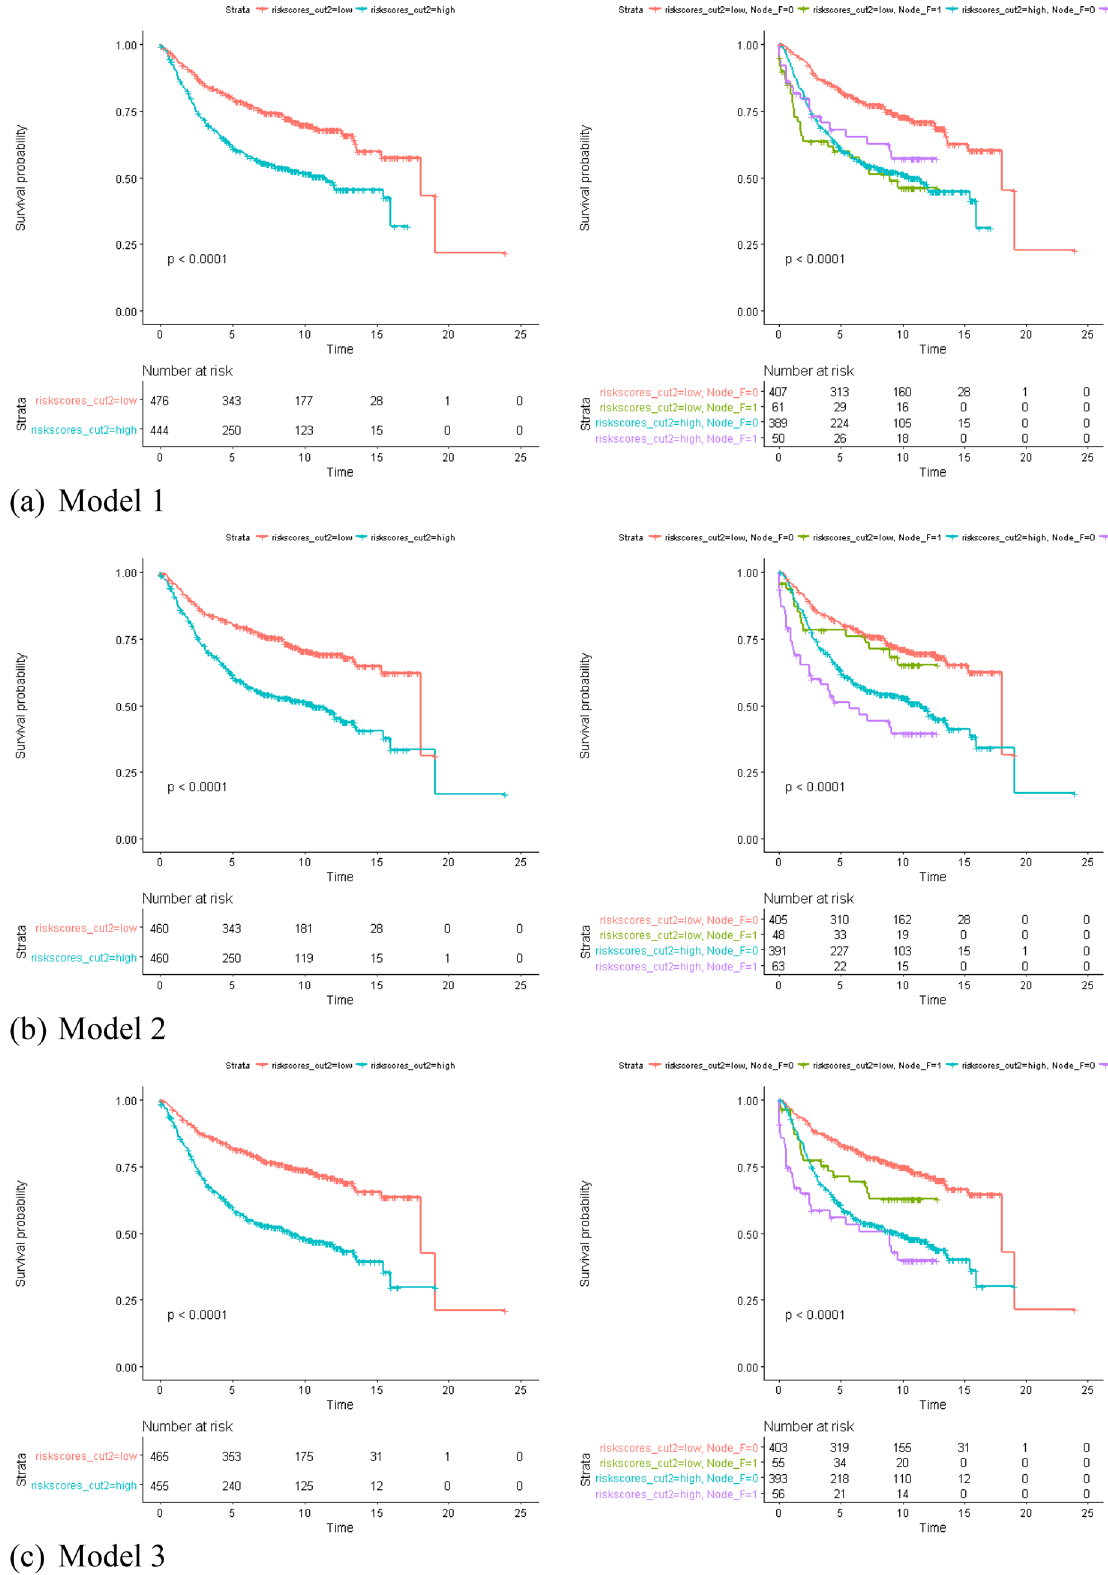
Figure 2. Partial cox regression plots of Models 1–5 and Model from Chou’s study 28